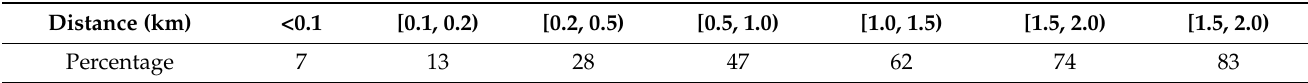
Table 1. Percentage of the flood-disturbed areas within a certain distance to the nearest stream. Distance (km)